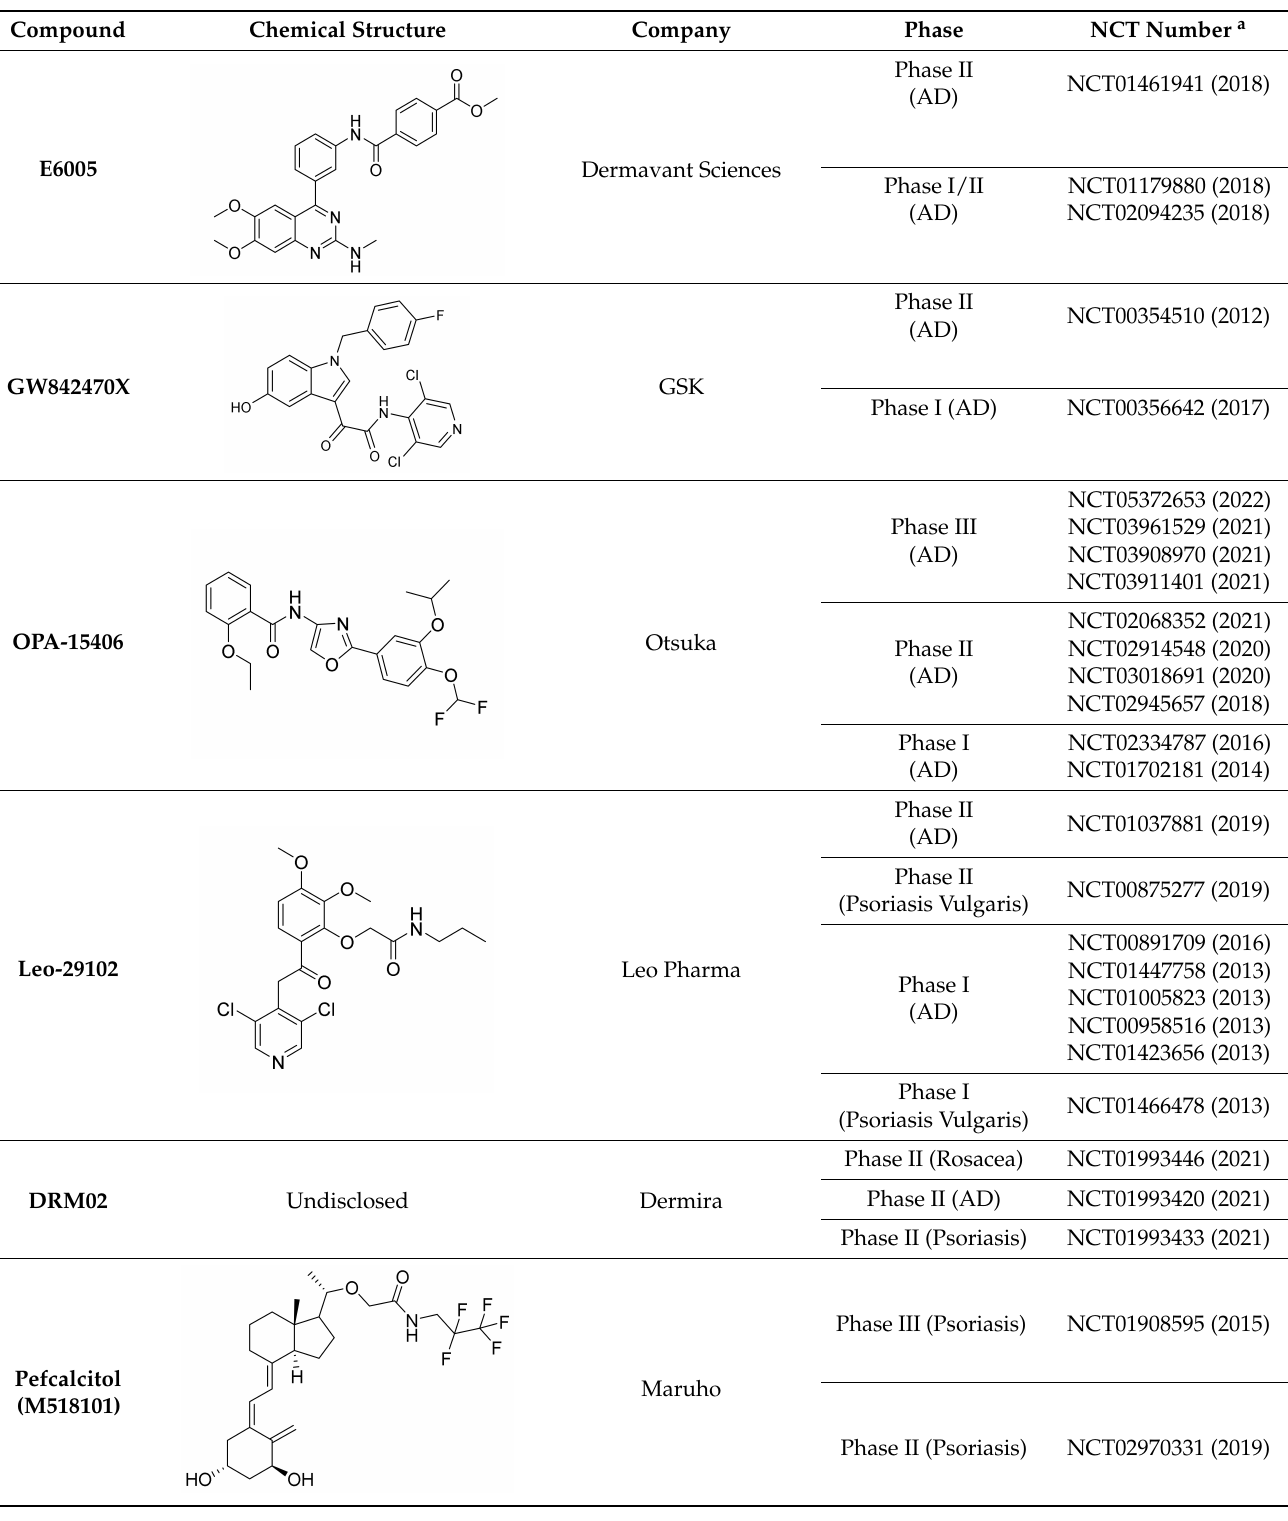
Table 2. PDE4 inhibitors under development for the treatment of atopic dermatitis (AD) and psoriasis.